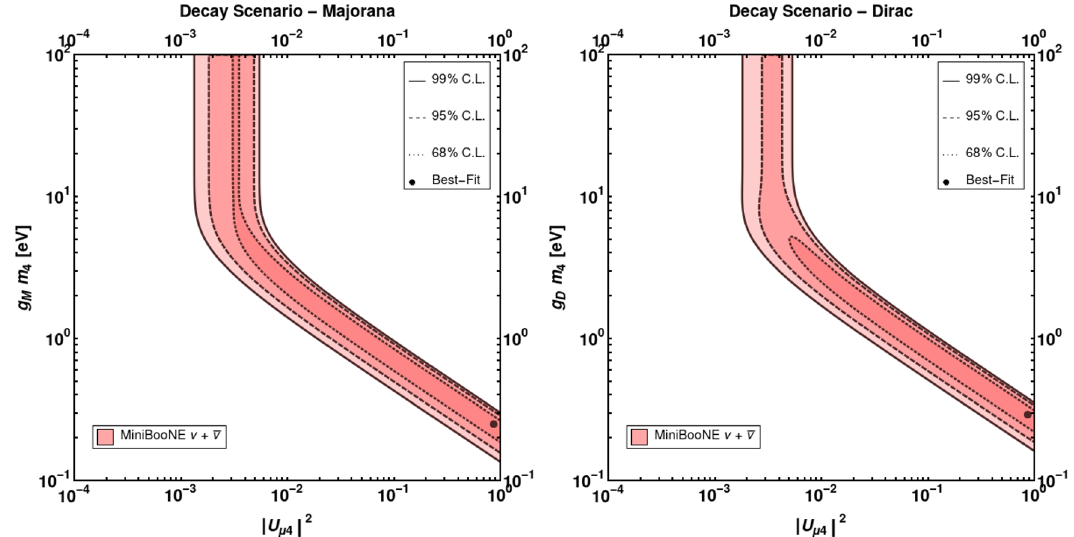
Figure 6 . Allowed regions of the ( j U (cid:22) 4 j 2 ; gm 4 ) parameter space when the decaying-sterile-neutrino hypothesis is matched against the combined MiniBooNE neutrino-mode and antineutrino-mode data assuming Majorana (left) or Dirac neutrinos (right). The dots indicate the best-(cid:12)t-point and the lines represent the 99% (solid), 95% (dashed) and 68% (dotted) C.L.